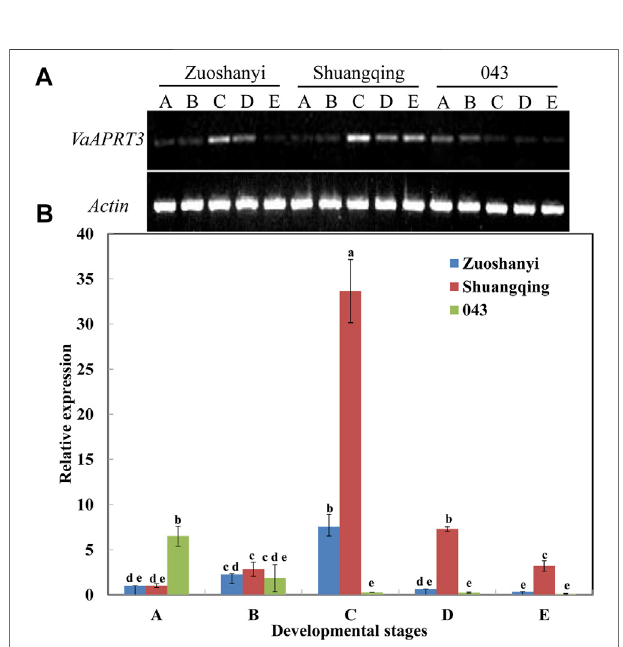
FIGURE 6 | Expression of VaAPRT3 gene. (A) Semi-quantitative PCR results, (B) qRT-PCR results. Capital letters A to E correspond to the fi ve developmental stages in Figure 1 . Lowercase letters are a marker for the signi fi cant differences at the 0.05 level among three sexes at each single